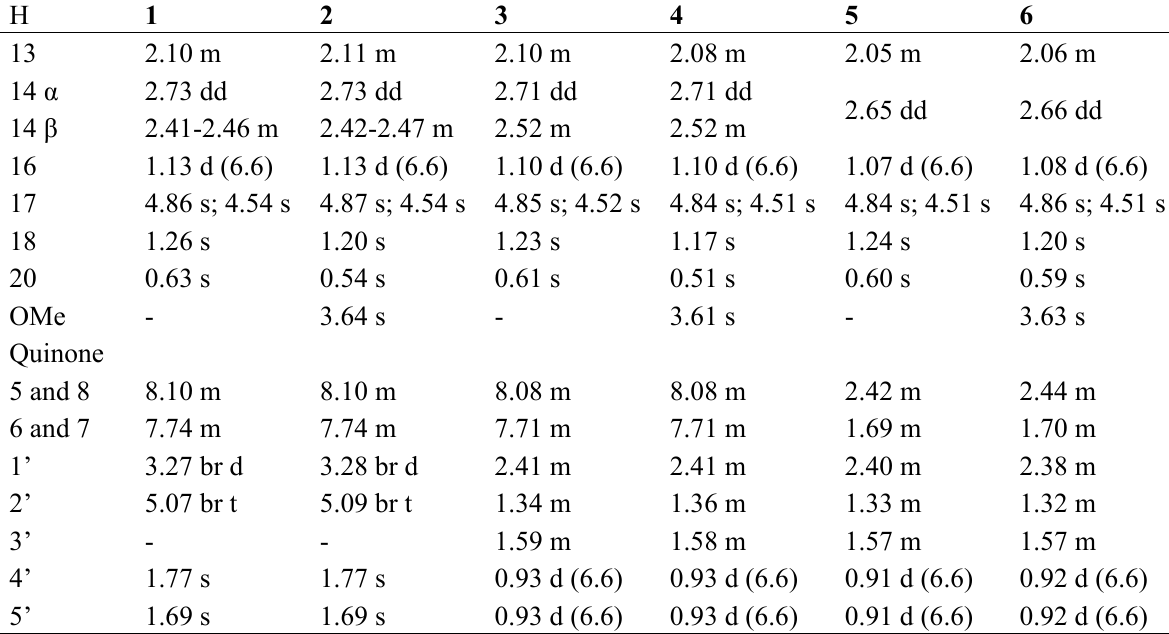
Table 3. Selected 1 H-NMR data of compounds 1–6